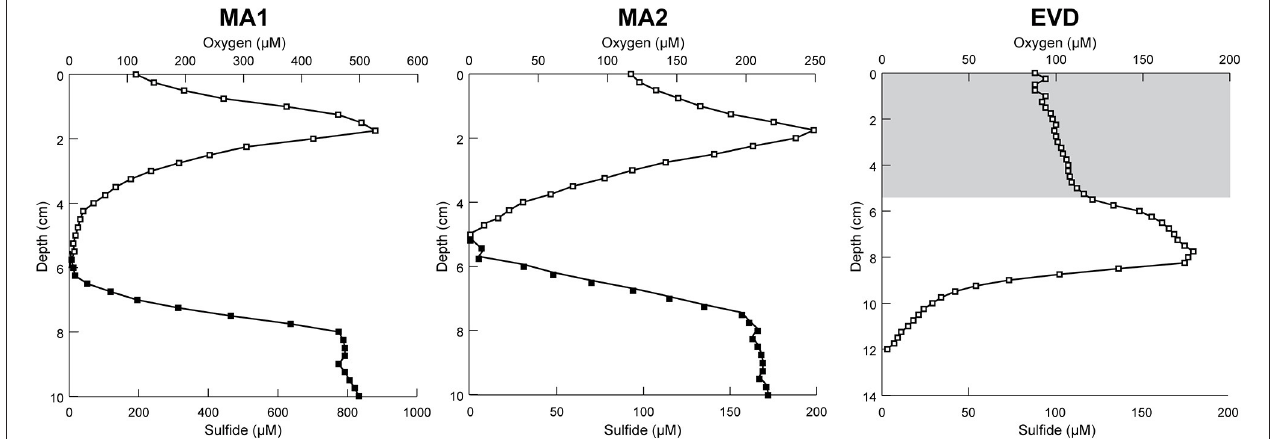
FIGURE 3 | Representative depth profiles of the concentration of O 2 ( squares ) and sulfide ( triangles ) measured in situ with microelectrodes during the light period. The gray shaded area depicts the mineral crust in